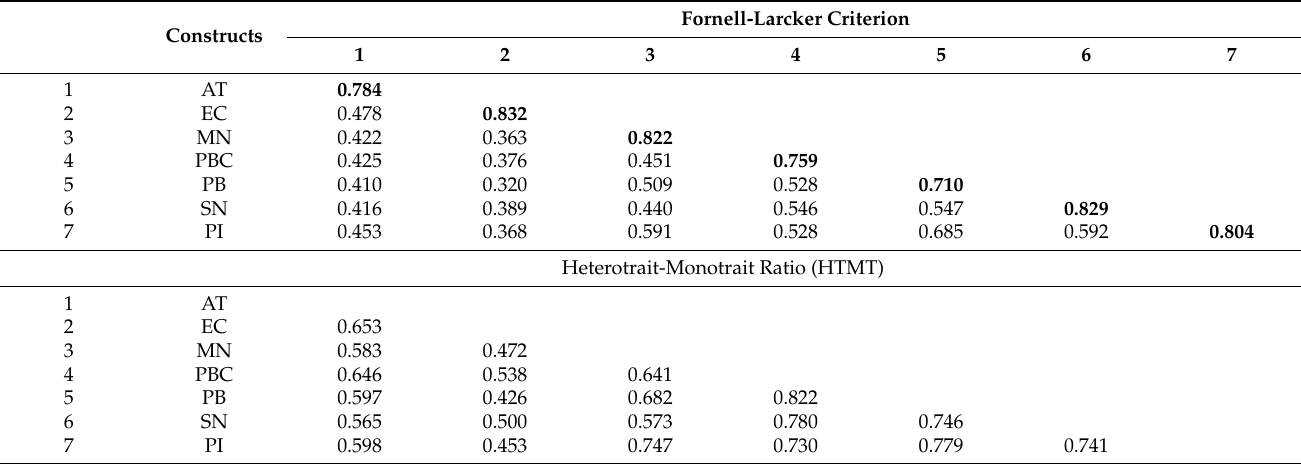
Table 4. PLS results of discriminant